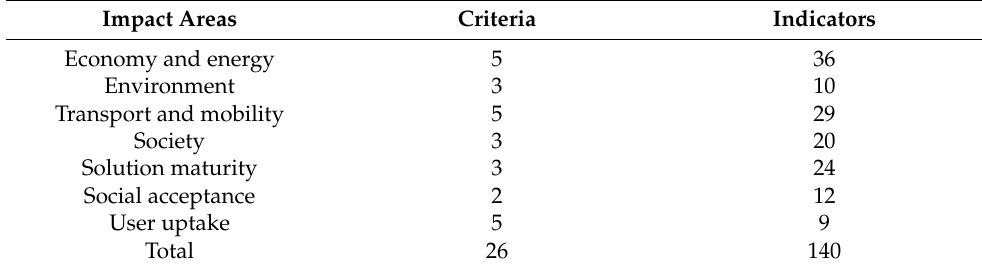
Table 4. Number of criteria and indicators per impact area.